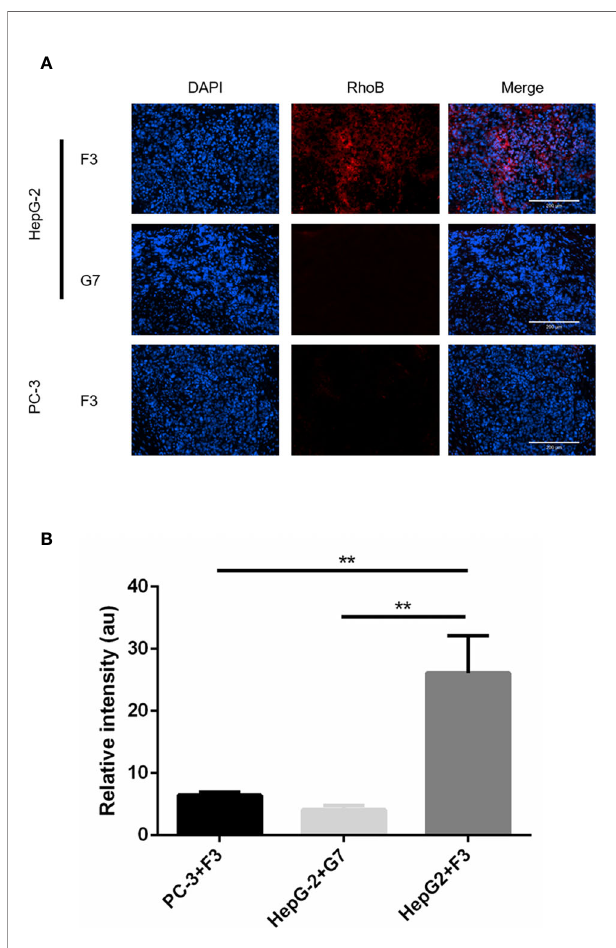
FIGURE 4 | In vivo tumor targeting of RhoB-F3 peptide. (A) Fluorescent staining for subcutaneous tumor cryosections after 1 h intravenous injection of RhoB labeling peptides (red). Accumulation of RhoB-F3 (red) in HepG-2 tumors was much stronger than that in PC-3 tumors. Nuclei were stained with DAPI (blue). Scale bars: 200 µm. (B) Analysis of RhoB fl uorescence intensity using Image J software. Accumulation of RhoB-F3 in PC-3 tumors and RhoB-G7 in HepG-2 tumors relative to RhoB-F3 in HepG-2 tumors (n = 5 per group, HepG-2+F3 to PC-3+F3, p = 0.0018, **p < 0.01, two-tailed Student ’ s t-test) (n = 5 per group, HepG2+F3 to HepG-2+G7, p = 0.0011, **p < 0.01, two-tailed Student ’ s t-test). All data represent the means ± standard error. P-value was calculated by two-tailed Student ’ s